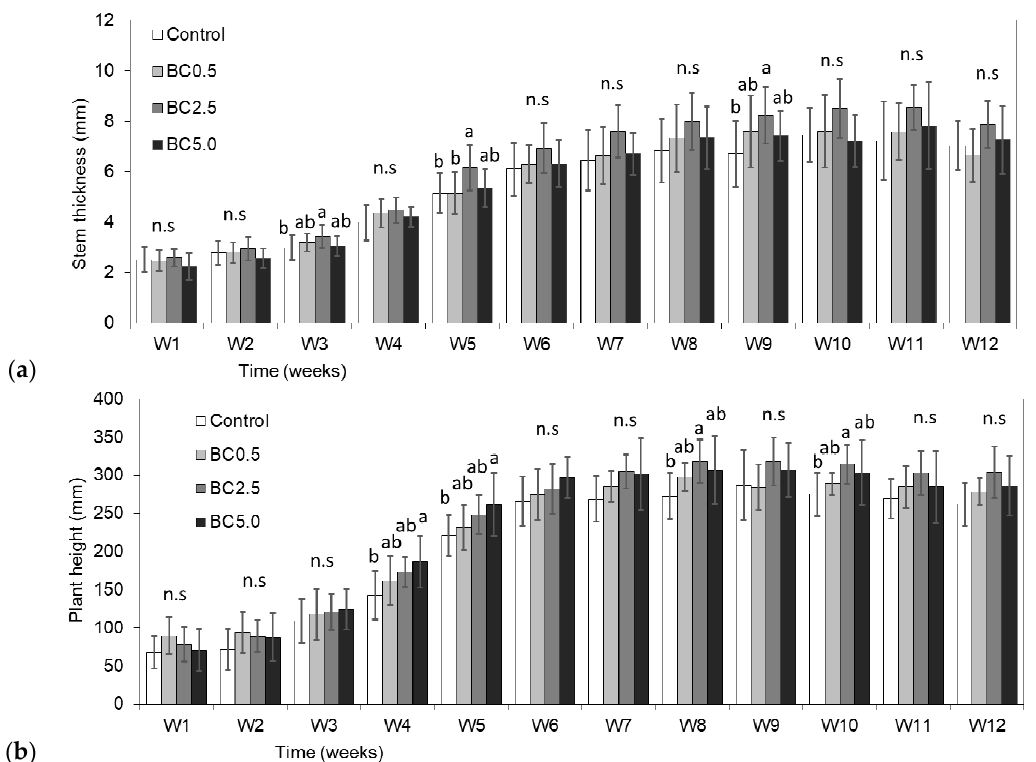
Figure 2. Plant growth values based on Capsicum annuum L. ( a ) stem thickness and ( b ) plant height collected weekly. n = 8 to 14; Mean, ±SD. Statistically significant differences ( p < 0.05) are indicated by different letters, while n.s. signifies not significant differences between treatments. Table 2. Average plant growth parameter measurements for the control and biochar (BC) amended treatments at the end of the experiment. Statistically significant differences are indicated by different letters. SD is the standard deviation of the data. One-way ANOVA, Tukey post-hoc test, n = 8. Treatment Plant Height 1 Stem Thickness 1